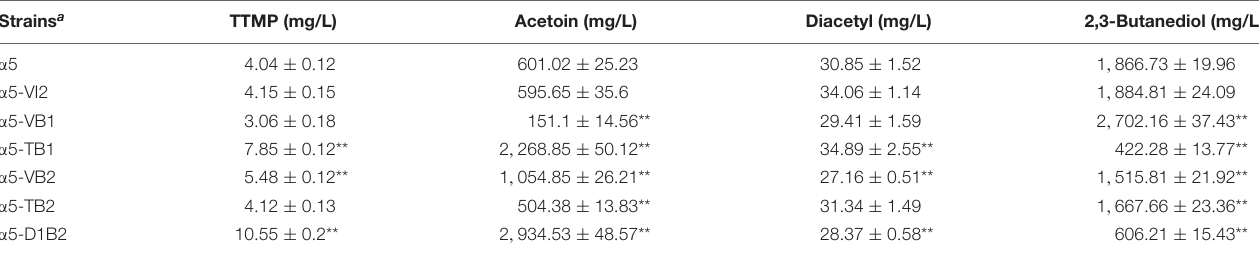
TABLE 2 | The concentrations of TTMP and other metabolites produced by haploid strains.